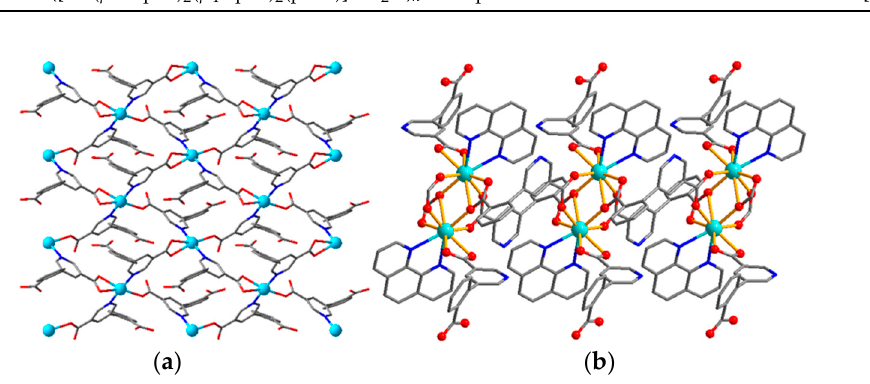
Figure 7. ( a ) 2D metal-organic layer in 34 . ( b ) 1D double chain in 35 . Adapted from [42].